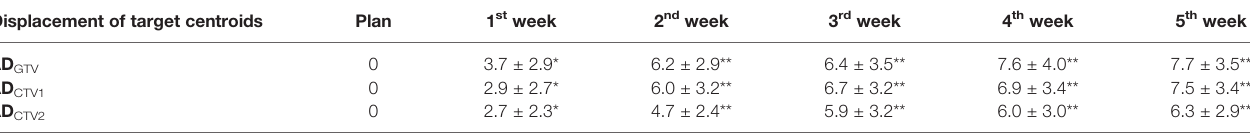
TABLE 3 | Position changes of target centroids (mm).